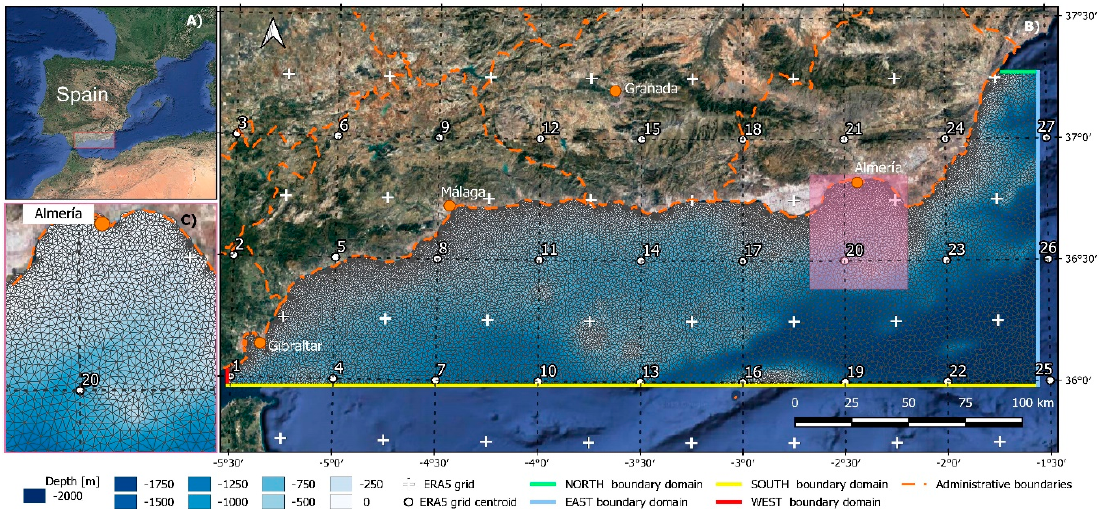
Figure 1. ( A ) General view of the numerical domain area used in this paper. ( B ) Numerical domain and triangular mesh sides; white dots represent the ERA5 data grid points and white crosses represent the corner of each grid. ( C ) Detail of the Delaunay triangulation used for the Gulf of Almeria.